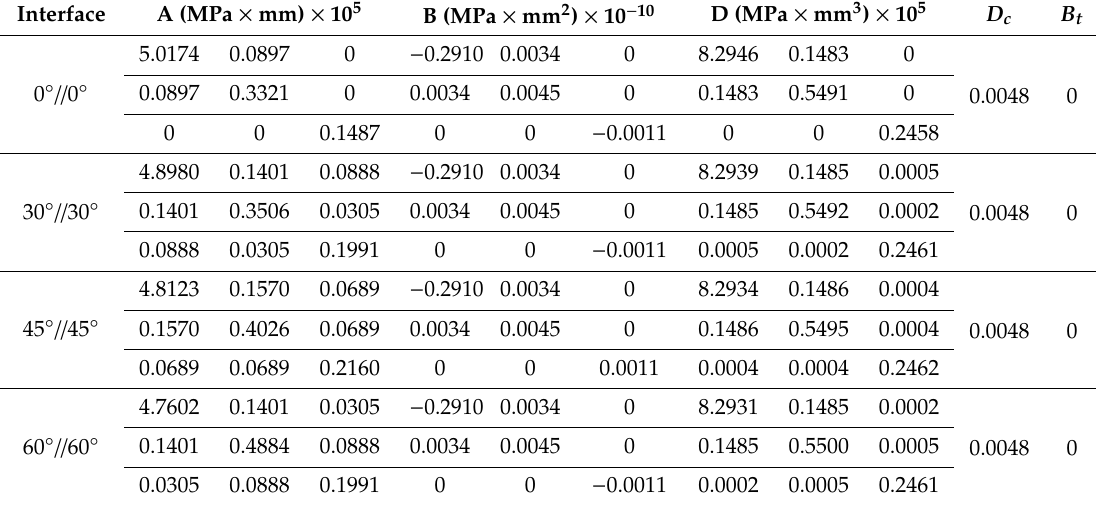
Table 3. Values of the sti ff ness matrices components calculated for the laminates with di ff erent delamination